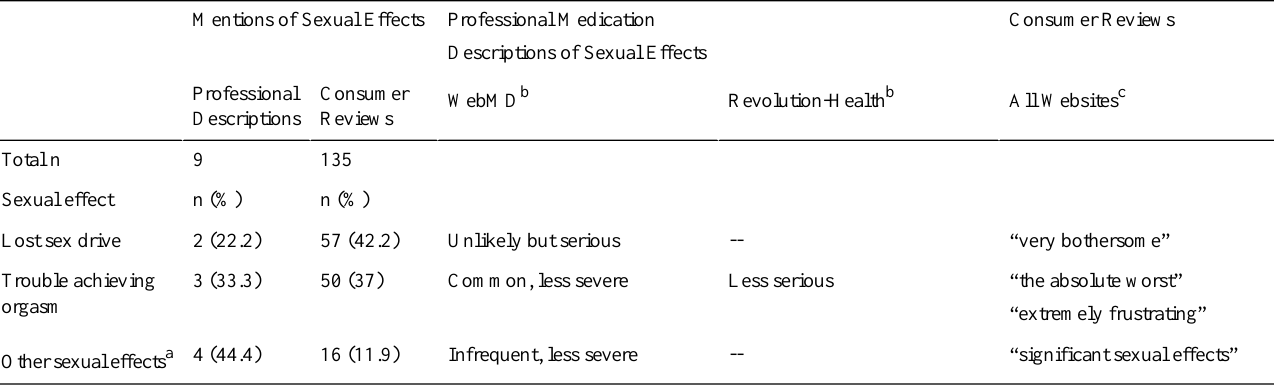
Table 6. Sexual effects of escitalopram according to consumer-generated and professionally controlled